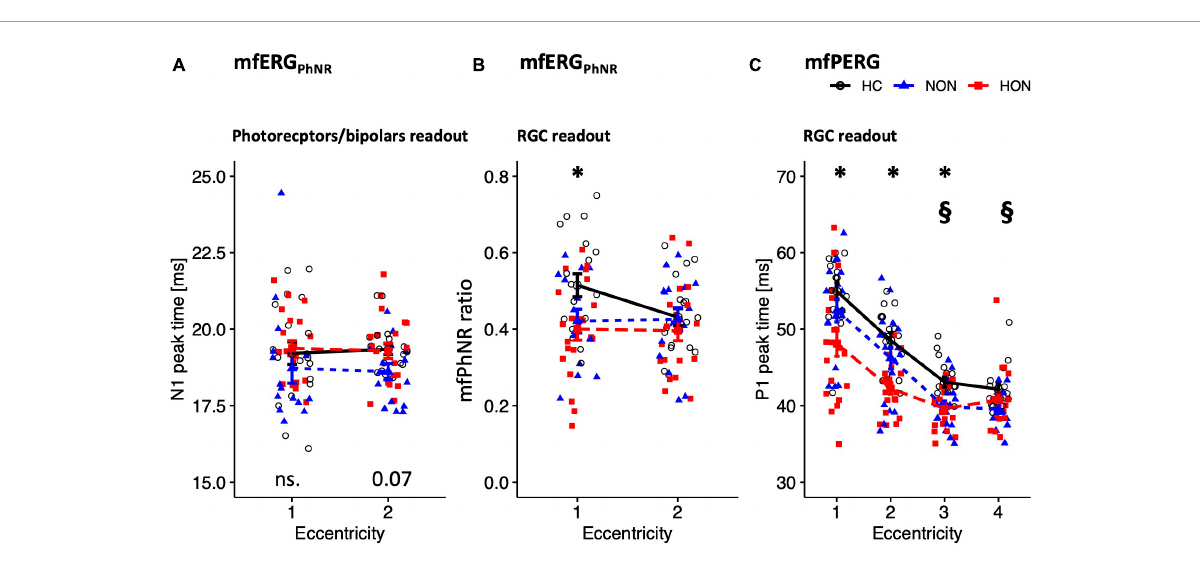
F (2,49) = 3.4, P = 0.042, respectively. Post hoc tests specified that the difference was driven by a reduction for NON vs. HC [ P <